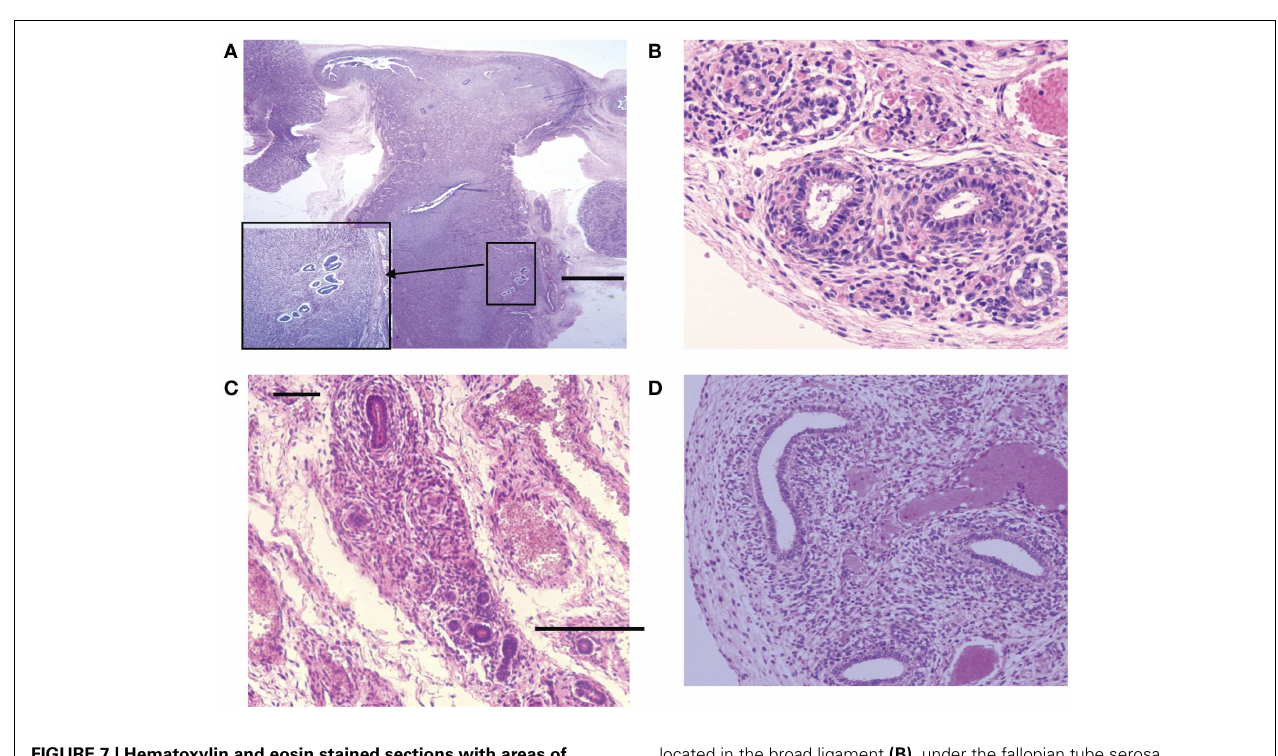
FIGURE 7 | Hematoxylin and eosin stained sections with areas of ectopic endometrial glands and embryonic ducts . Histological appearance of ectopic glands and stroma observed (insert at higher magnification) in fetal uterine wall (A) . Presence of embryonic ducts